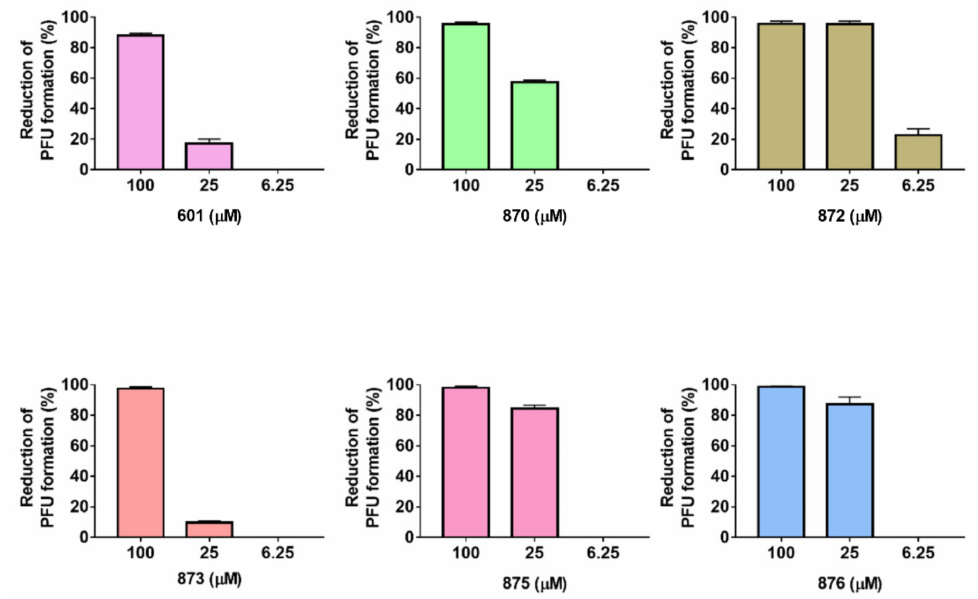
Figure 2. Antiviral Efficacy of Test Compounds in a Plaque Reduction Assay against Omicron SARS- CoV-2. Various dilutions of the test compounds were added to Vero E6 cells, after which the cells were infected with 50 p.f.u./well for 1 h. Then, the residual virus was removed and the cells were overlaid with 0.7% CMC containing the indicated dilutions of the compounds. After 72 h of infection, the wells were fixed with formalin, stained with crystal violet, and plaques were counted. Results are representative of n = 3 and are mean ± SEM.